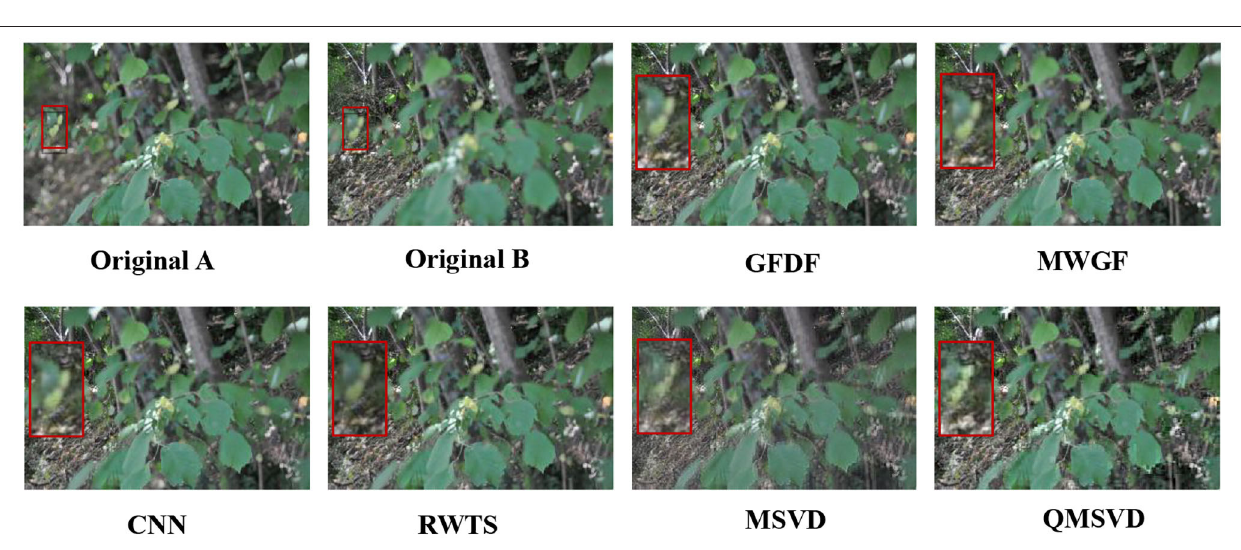
FIGURE 9 | “Forest” fusion images obtained by six different fusion